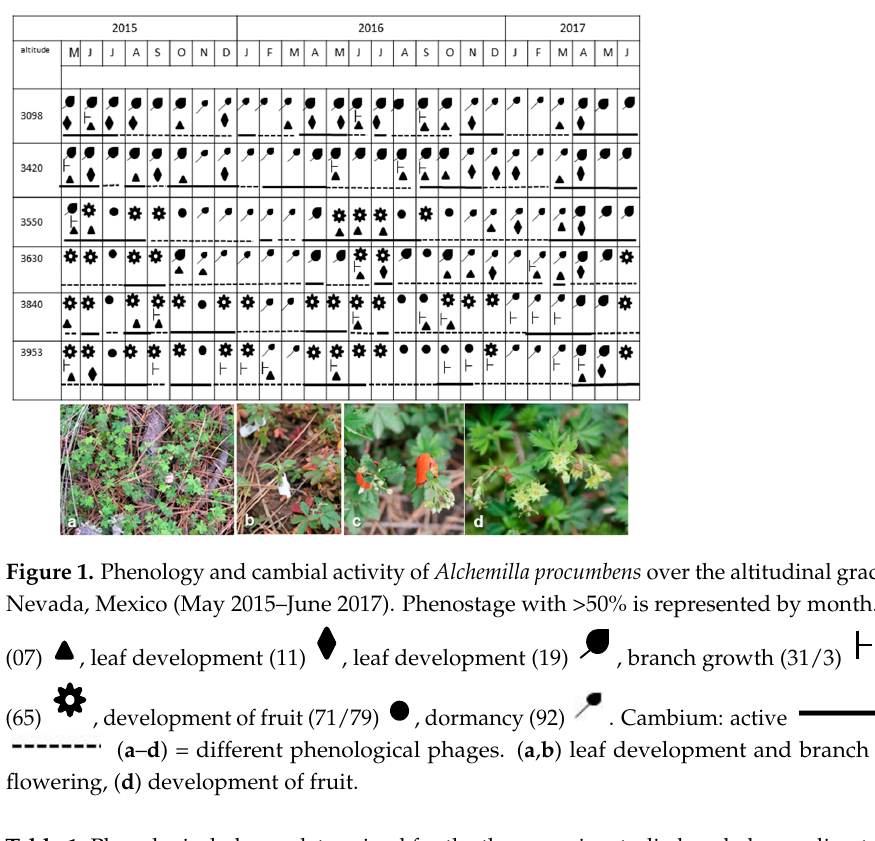
Table 1. Phenological phases determined for the three species studied, coded according to Meier [30]. Some of these phenophases are illustrated in Figures 1–3.